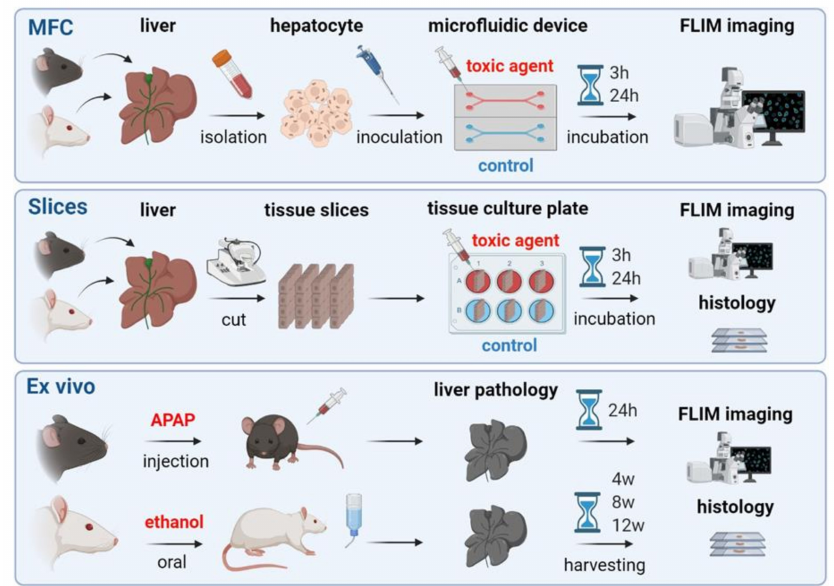
Figure 2. Road map of the steps implemented to study hepatotoxicity using different models. (Microfluidic chip: upper row, slices: middle row, ex vivo: bottom